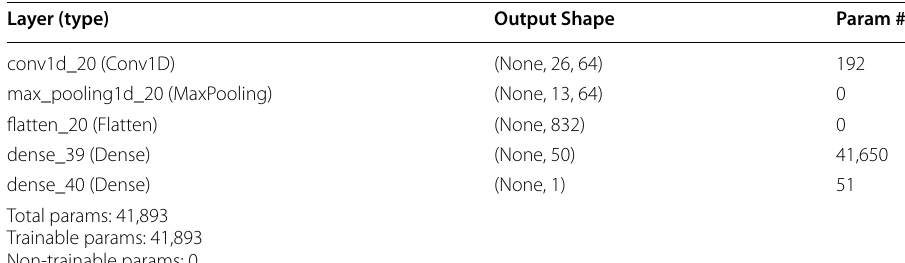
Table 4 Summary of CNN Model